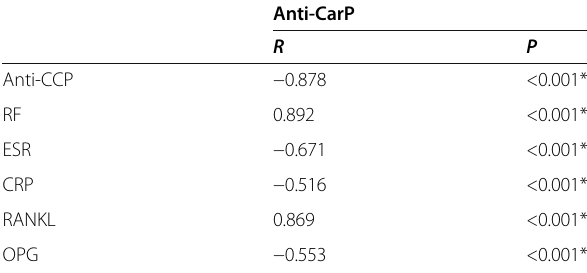
Table 4 Correlation between Anti-CarP antibodies and laboratory findings: It showed significant positive correlation with RF and RANKL and negative correlation with other parameters as performed by Spearman ’ s test